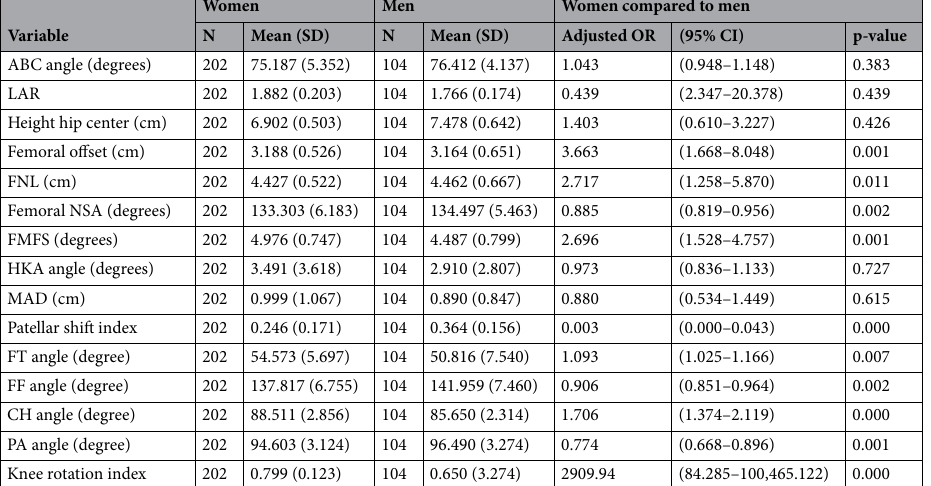
Table 3. Different parameters of women compared to those of men. ABC Abductor angle, LAR Lever arm ratio, FNL Femoral neck length, NSA neck-shaft angle, DHCFA/R distance from the femoral head center to the femoral axis, divided by the radius, FMFS angle between the femoral mechanical axis and the femoral shaft axis, HKA hip-knee-ankle angle, MAD mechanical axis deviation, FT fibular-tibial angle, FF fibular-femoral angle, CH condylar-hip angle, PA tibial plateau-ankle angle, OR odds ratio, CI confidence